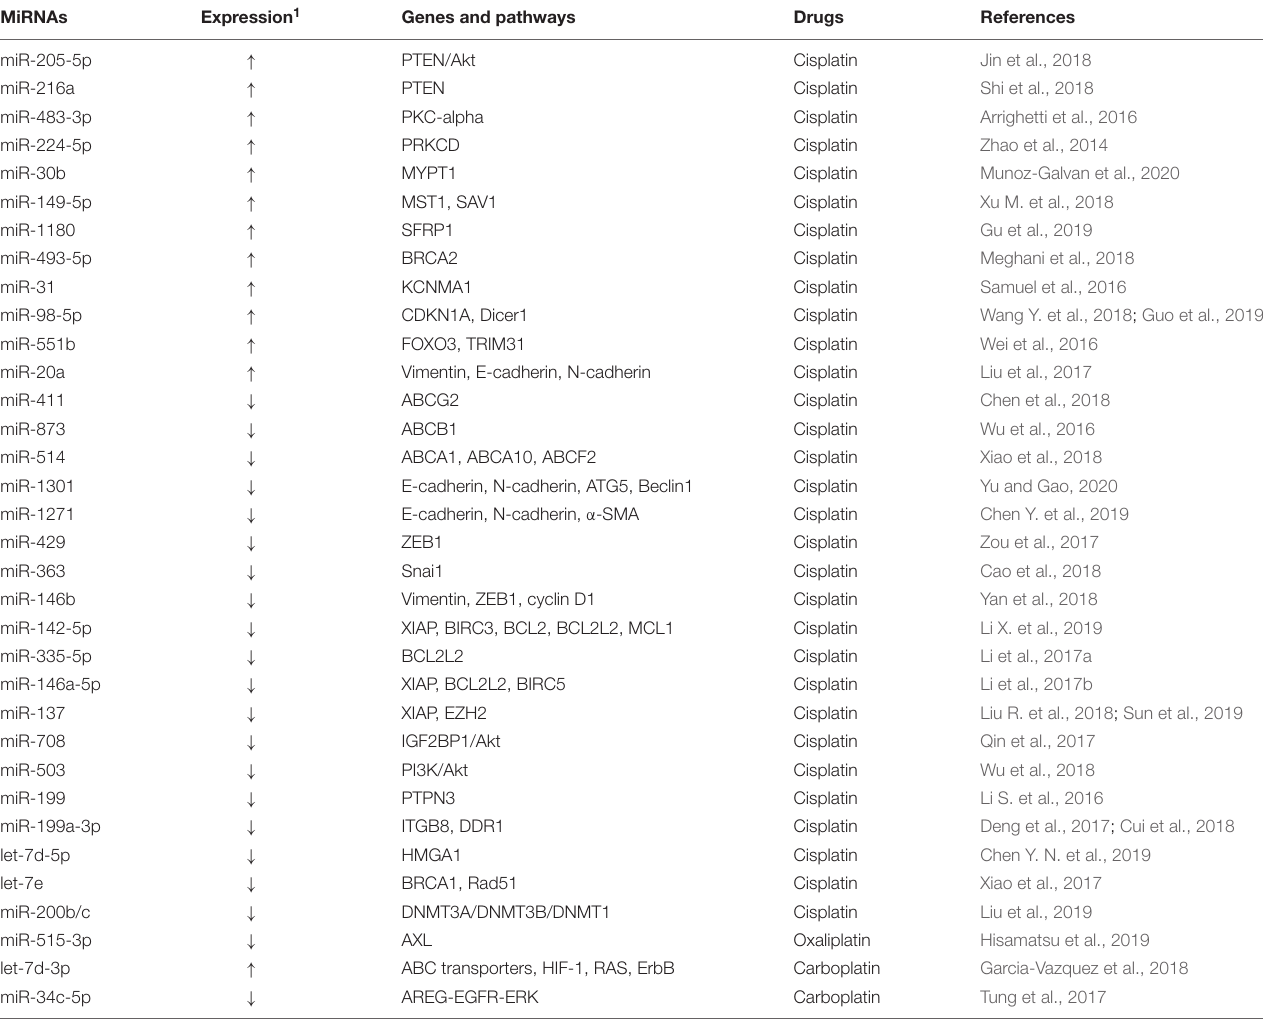
TABLE 1 | MiRNAs and platinum resistance in ovarian